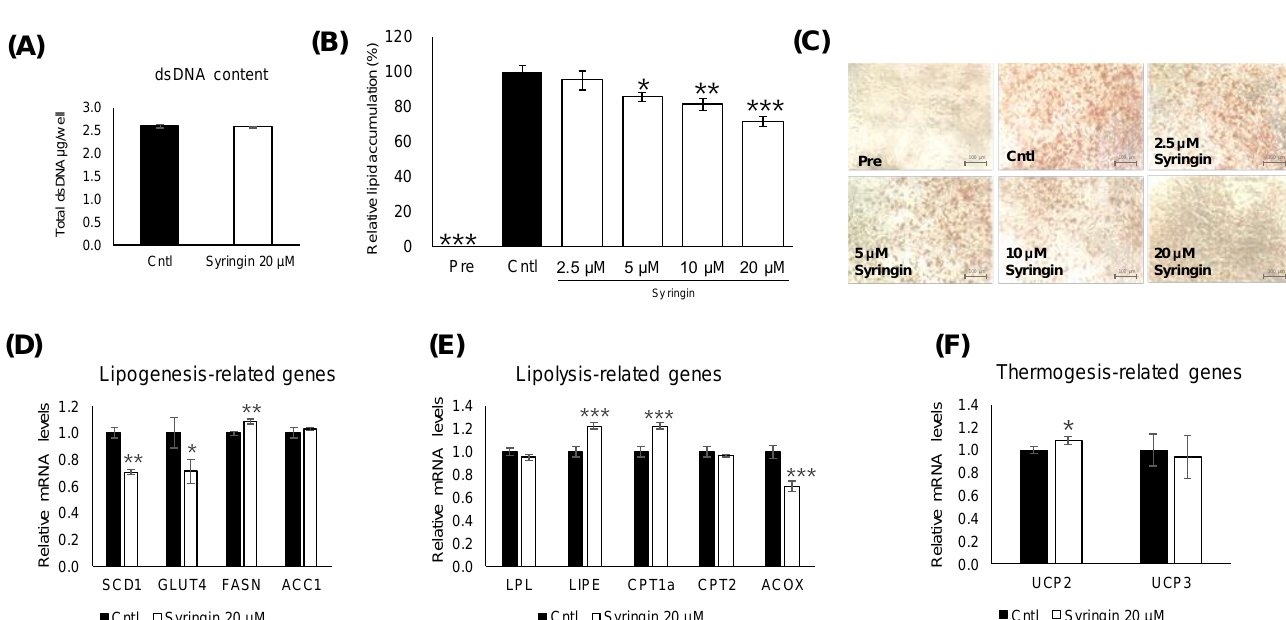
Figure 4. Effect of syringin on adipogenic differentiation through the regulation of adipogenic factors in 3T3-L1 cells. ( A ) Cytotoxic effect of syringin on 3T3-L1 cells. ( B , C ) Cellular lipid accumulation by Oil Red O staining (image 20 × magnification and scale bar = 100 µ m). ( D – F ) mRNA levels of ( D ) lipogenesis-, ( E ) lipolysis-, and ( F ) thermogenesis-related genes. Experiments were performed in triplicate. The results are presented as means ± SEM of three independent experiments ( n = 3). The asterisk (*) indicates a significant difference between control and treatment groups by Dunnett’s test and Student’s t-test . * p < 0.05, ** p < 0.01, and *** p < 0.001 vs. control (Cntl) and preadipocytes (pre).